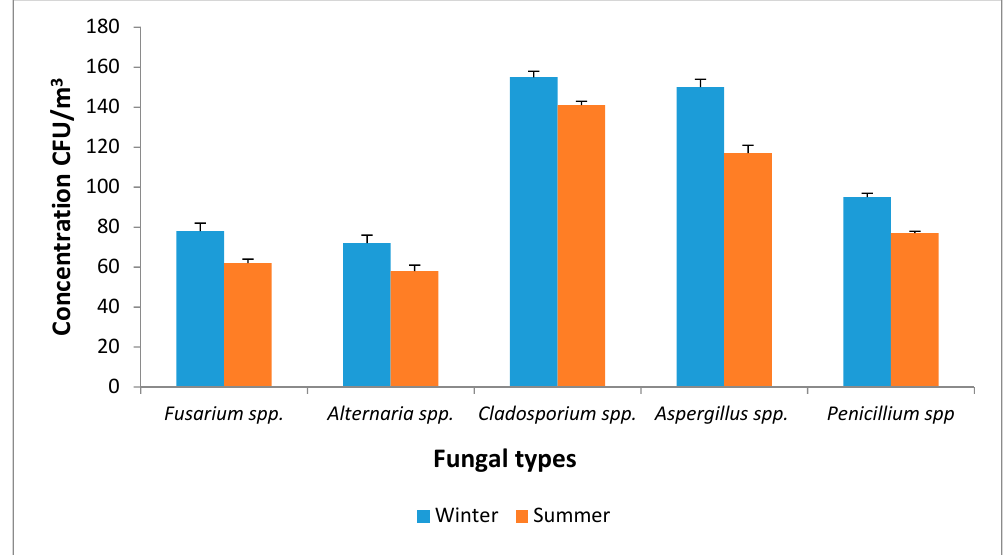
Figure 5. Concentration of isolated fungal ‐ bound PM 2.5 in Pretoria West